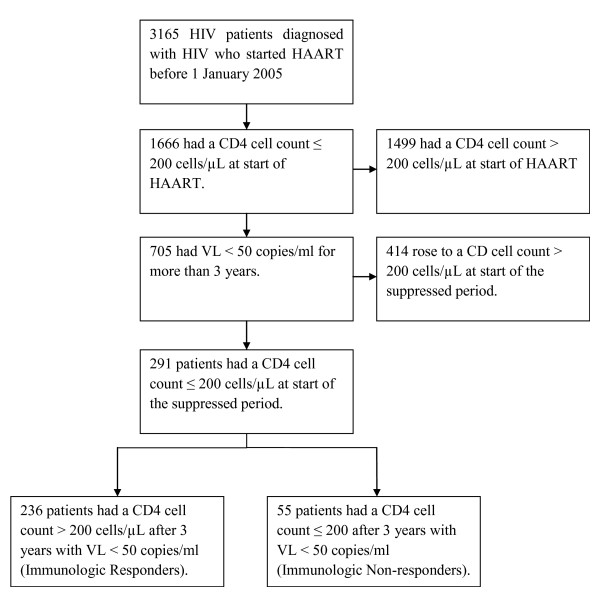
Study flow chart.